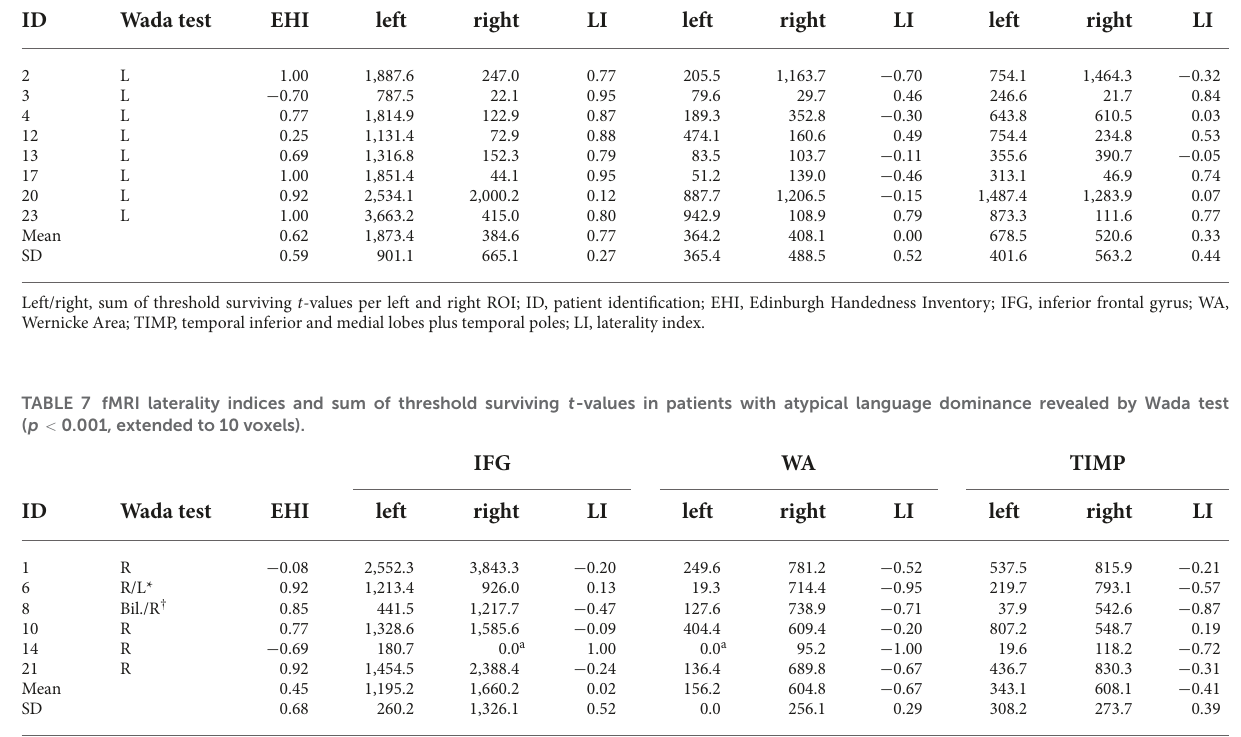
TABLE 6 fMRI laterality indices and the sum of threshold surviving t -values in patients with left language dominance revealed by Wada test ( p < 0.001, extended to 10 voxels). IFG WA TIMP ID Wada test EHI left right LI left right LI left right LI